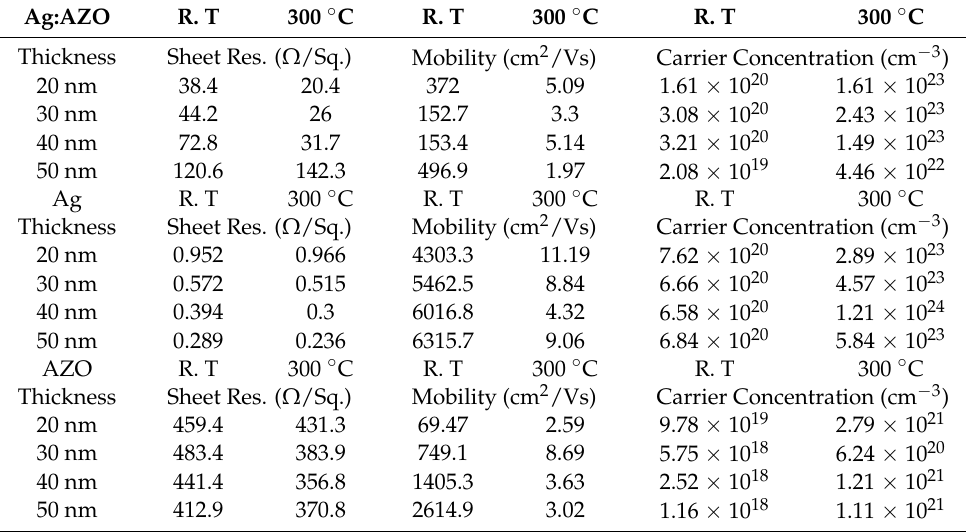
Figure 4. Optical characteristics of as-deposited electrodes by thickness. ( a ) Transmittance of Ag:AZO Table 4. Electrical properties of as-deposited electrodes. Ag:AZO Sheet Res. ( Ω